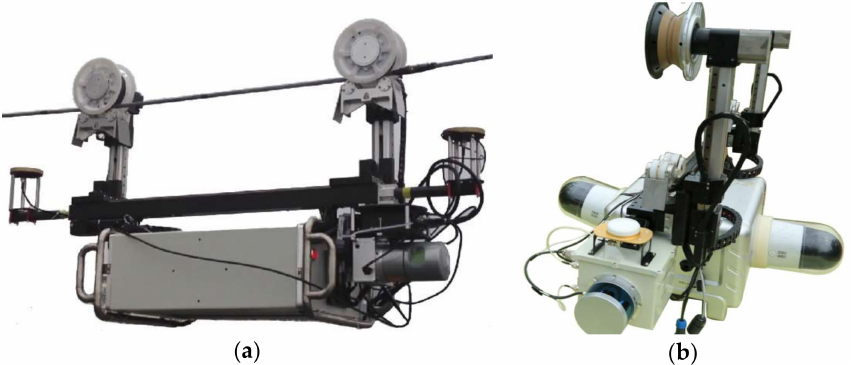
Figure 11. The two CIR LiDAR systems: ( a ) System 1; ( b ) System 2.